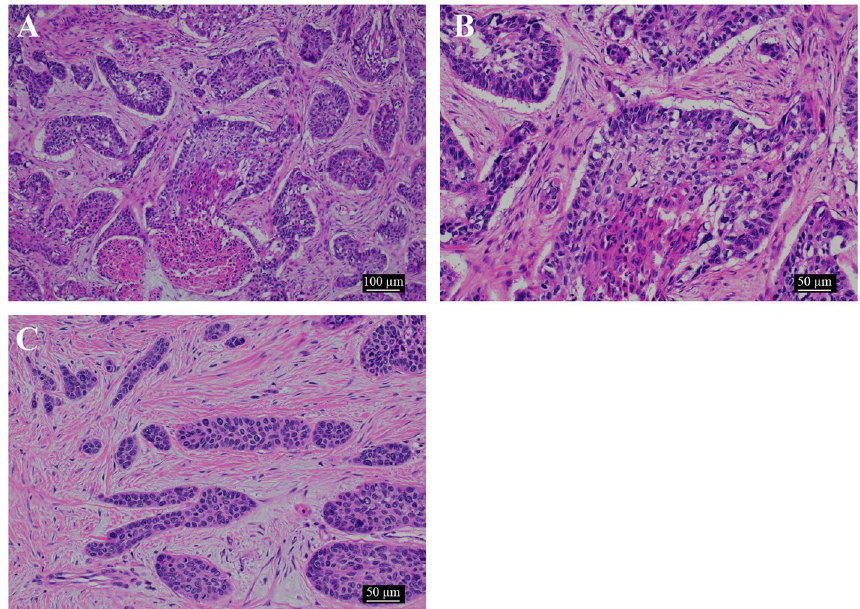
Fig. 9 Histological examination. a Part of the atypical epithelium is proliferating, forming small and large foci with necrosis ( of the tumor foci show a fenestrated arrangement, and enamel pulp-like structures and squamous metaplasia are seen in the center of the foci. It is accompanied by a high degree of atypia ( 200). c Some parts of the lesion grow while forming epithelial cords and epithelial islands, which × resemble dental crests ( 200). The position of the ameloblastic carcinoma is also visible ×